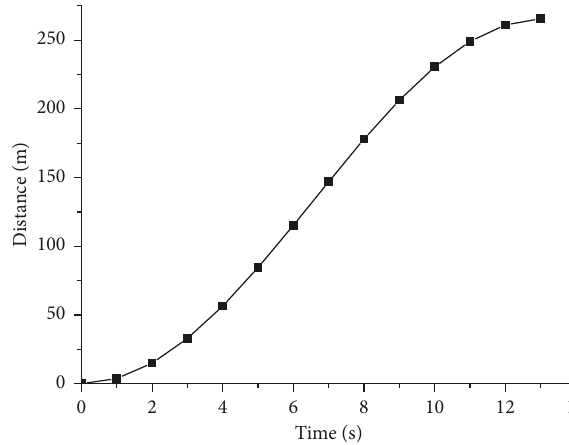
Figure 4: Changing curve of falling displacement of sacked gangue.